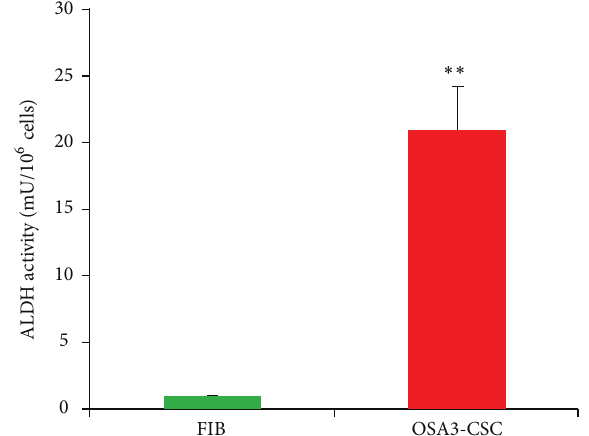
Figure 21: ALDH activity assay. The ALDH colorimetric assay detected high levels of ALDH activity in the cell lines of OSA3-CSCs and OSA6-CSCs while the assay detected the absence of this activity in the finite differentiated cell line of fibroblasts, FIB. Error bars: SD. ∗∗ p < 0.05 versus FIB.